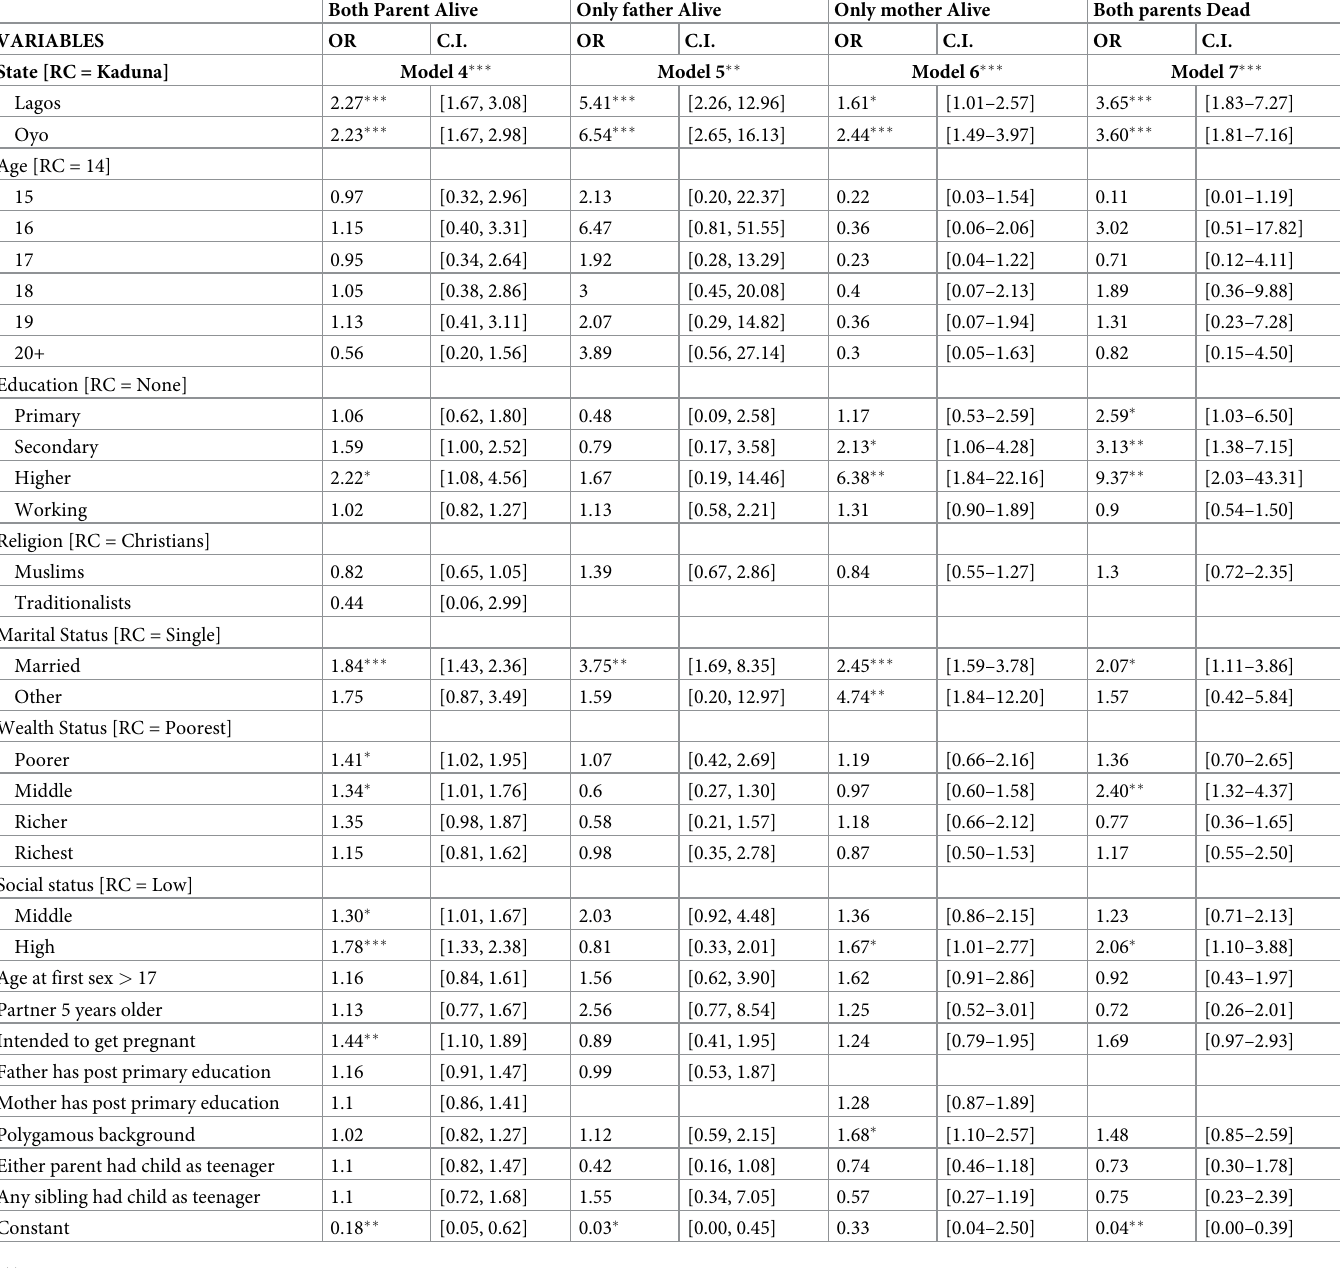
Table 6. Binary logistic regression analysis showing the effect of background and family variables on making at least 4 antenatal in facilities with skilled attendant, controlling for parents’